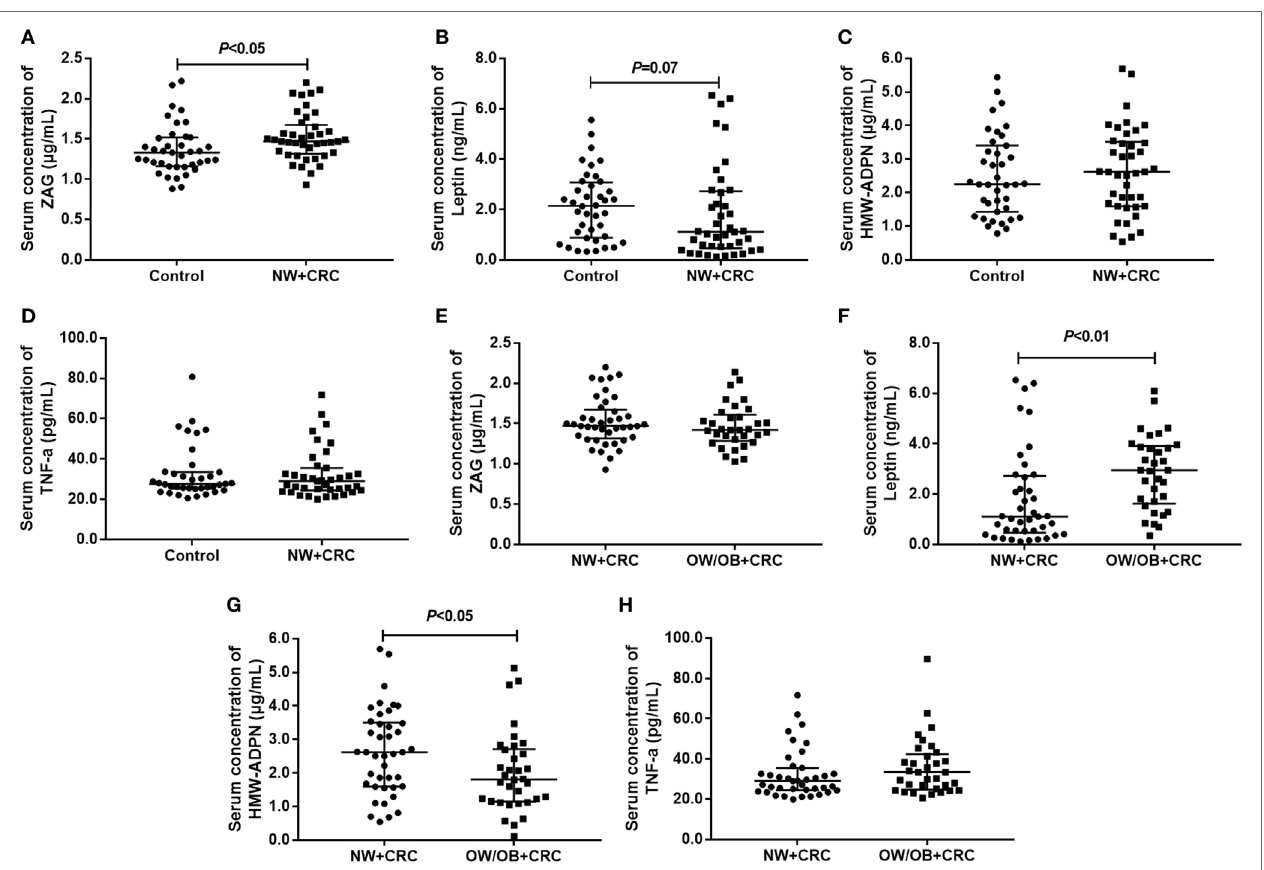
FigUre 1 | Serum levels of ZAG, leptin, HMW-ADPN, and TNF- α in NW + CRC patients and healthy controls (a–D) as well as in NW + CRC and OW/OB + CRC patients (e–h) . Abbreviations: ZAG, zinc- α 2-glycoprotein; HMW-ADPN, high-molecular-weight- adiponectin; TNF- α , tumor necrosis factor-alpha; NW, normal weight; OW/OB, overweight/obese; CRC, colorectal cancer. All values are expressed as the median with the interquartile